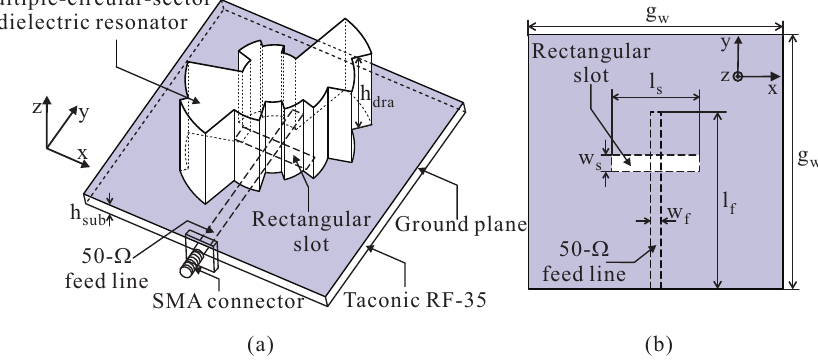
Figure 2. The geometry of the proposed antenna: ( a ) 3D view; ( b ) Feeding configuration. SMA: SubMiniature version A. Table 1. The optimized design parameters of the proposed